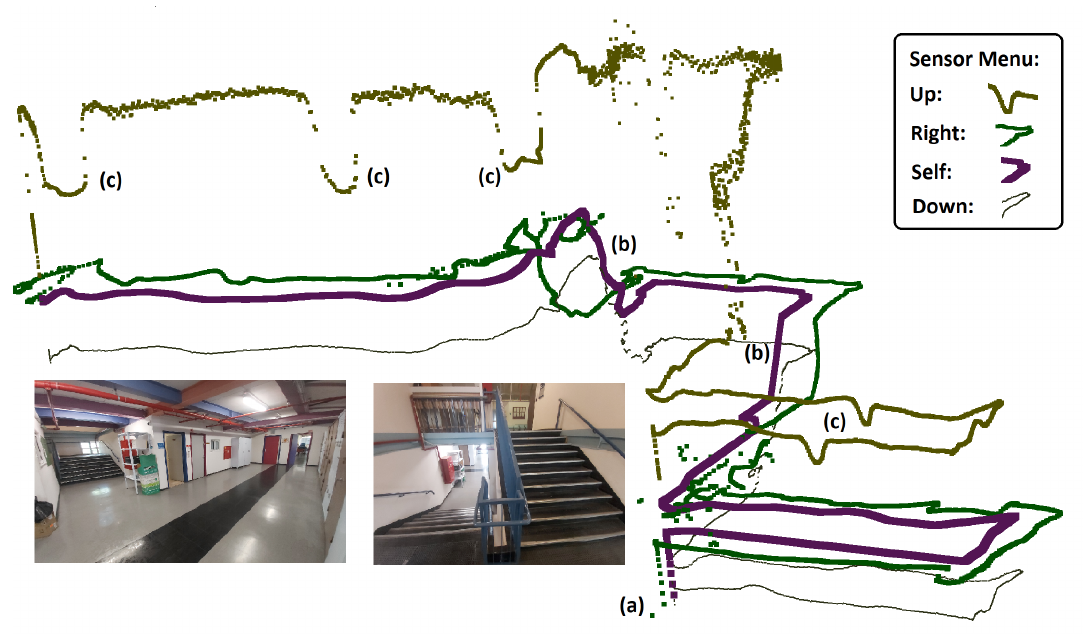
Figure 10. A 3D mapping of a two story building. BAT’s up, right, down and self position sensor-ranging are shown in brown, green, black and magenta lines, respectively. BAT’s starting point is marked by (a), (b) marks the stairs to the second floor—as shown in the lower right image. Changes in the ceiling height are marked by